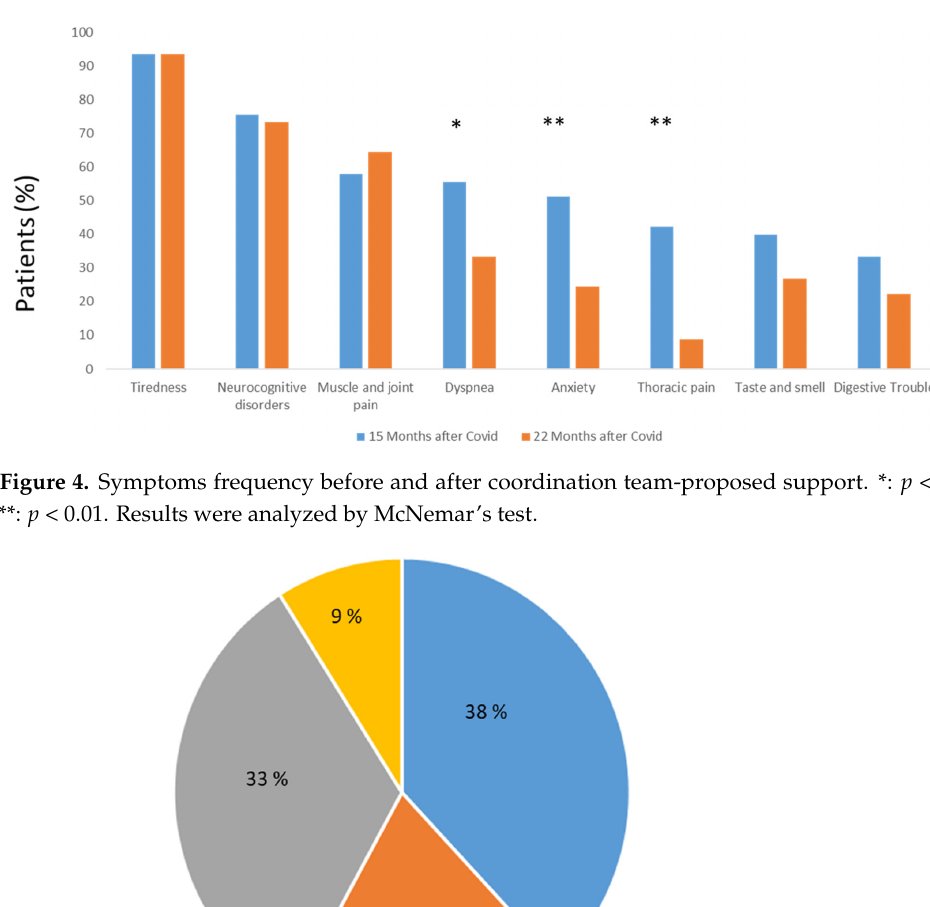
Figure 5. Patients’ perceived improvement.